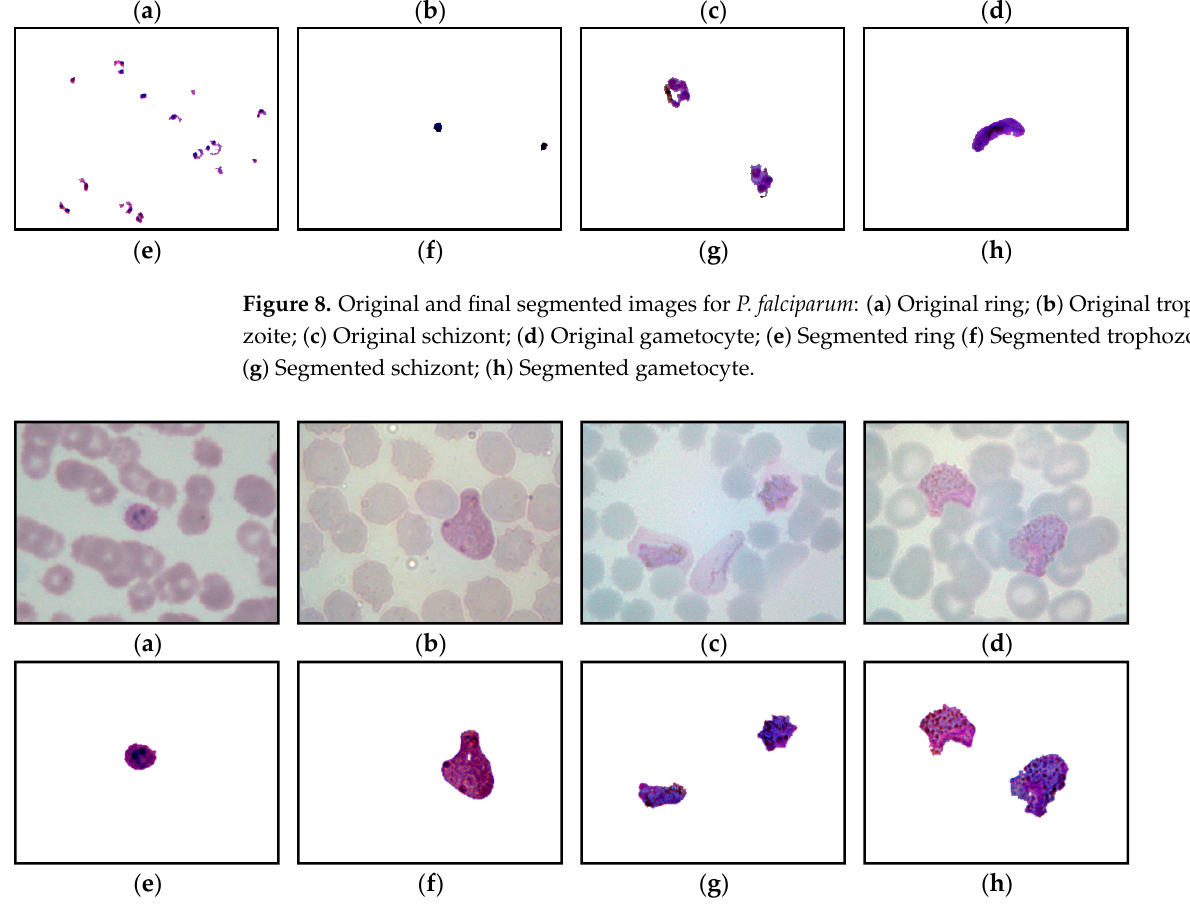
Table 7. The performance comparison among ELM, OS-ELM, and random forest networks for clas- sification between malaria and non-malaria parasites.